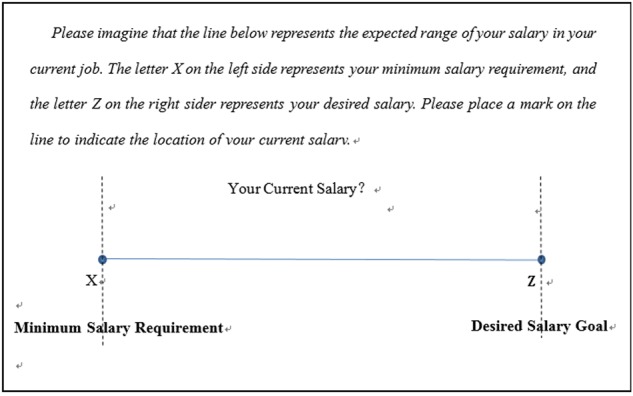
An analog scale of subjective pay discrepancies. Participants estimate and locate on the scale their salary status quo in relation to their salary goal and minimum requirement.